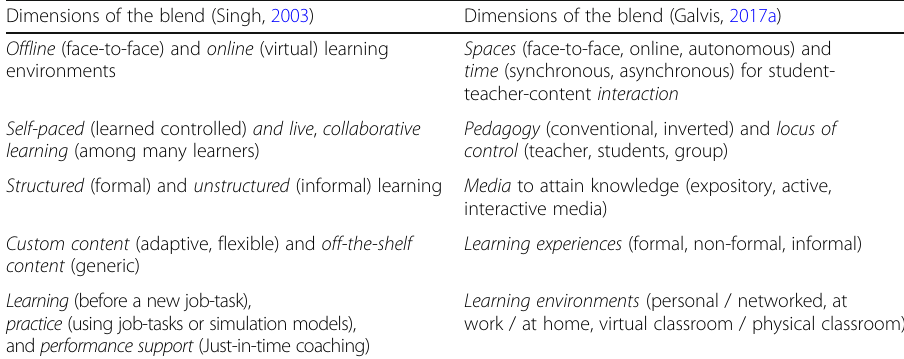
Spaces (face-to-face, online, autonomous) and time (synchronous, asynchronous) for student- teacher-content